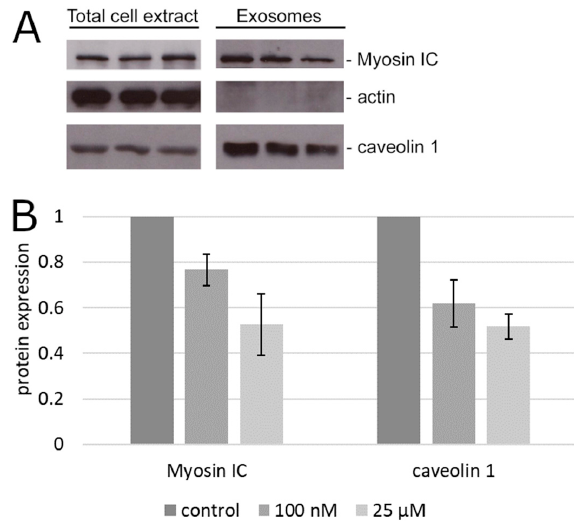
Figure 2. Content of advanced prostate cancer markers in the exosomal fraction. ( A ) Representative immunoblot of total cell extract and secreted exosomes. The protein content in the total extract of the adherent cells is shown for comparison with the exosomal fraction of the supernatant from the same cultures. ( B ) Densitometry of the results in ( A ). Error bars, standard error of the mean.